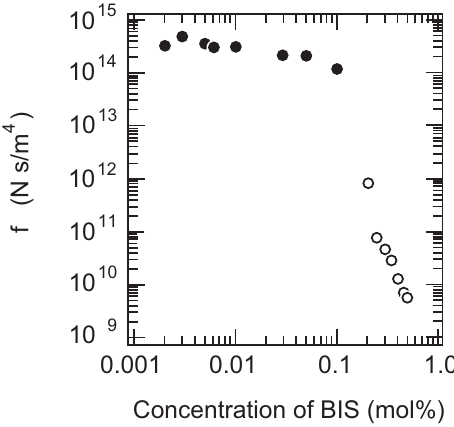
Figure 10. The cross-linker concentration dependence of the friction coefficient of PAAm gel at higher concentration region of BIS (open circles). The results shown in Figure 7 are also plotted in this figure (solid circles). The gels are prepared at a total concentration of 700 mM, and the mole fraction of the cross-linker is